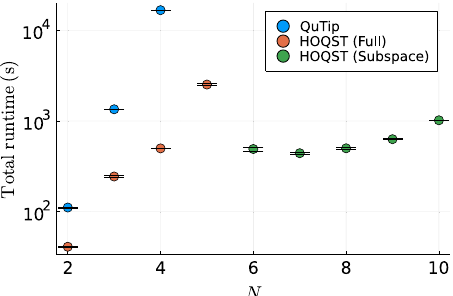
Fig. 2 Total runtime vs system size for the benchmark simulation of the alternating sectors chain problem. The x-axis ( N ) is the system size. Each data point corresponds to the average runtime of 7 – 10 runs. Error bars represent 5 standard deviations. The “ QuTiP ” and “ HOQST (Full) ” points represent the runtime of full adiabatic master equation (AME) simulations using the corresponding packages. The “ HOQST (Subspace) ” points represent the runtime of AME simulation in the lowest 20-level subspace. The benchmark was done on a desktop computer with an Intel(R)